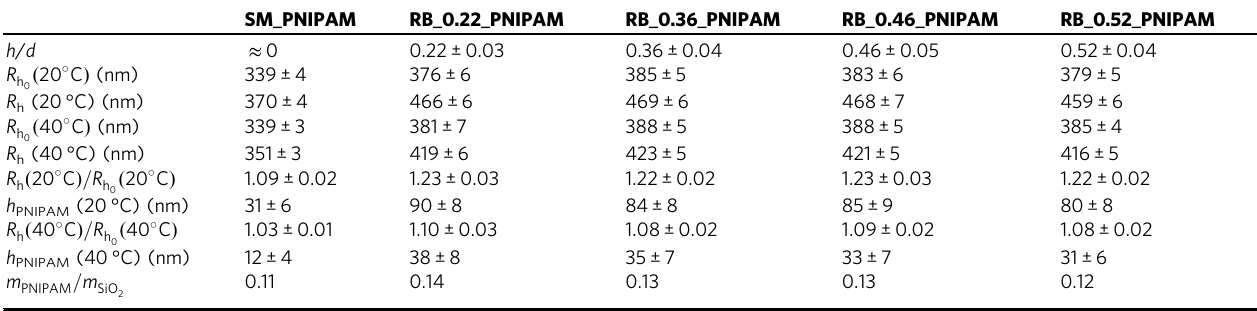
Table 1 Details of the PNIPAM-grafted